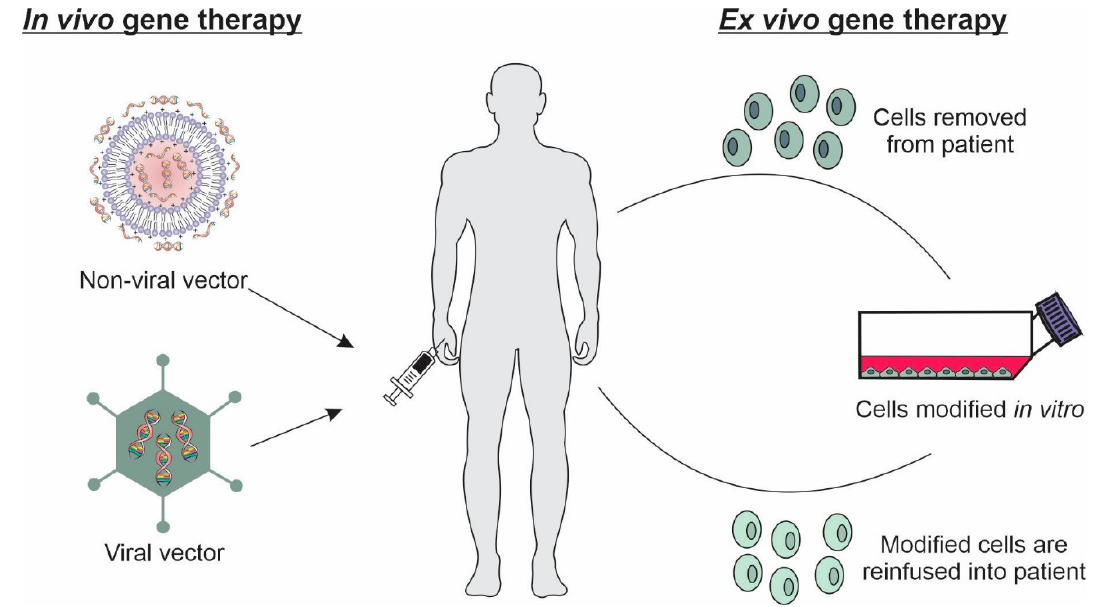
Figure 1. In vivo and ex vivo techniques related to gene delivery to target cells.